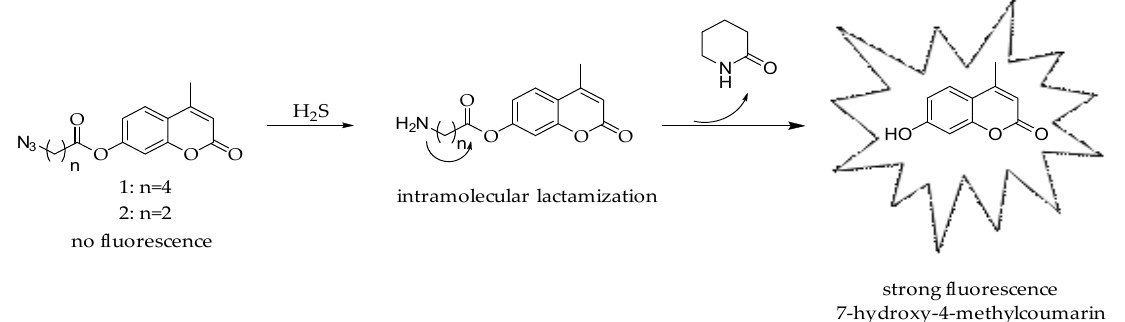
Figure 1. Mechanism of H 2 S detection for the self-immolative probe.